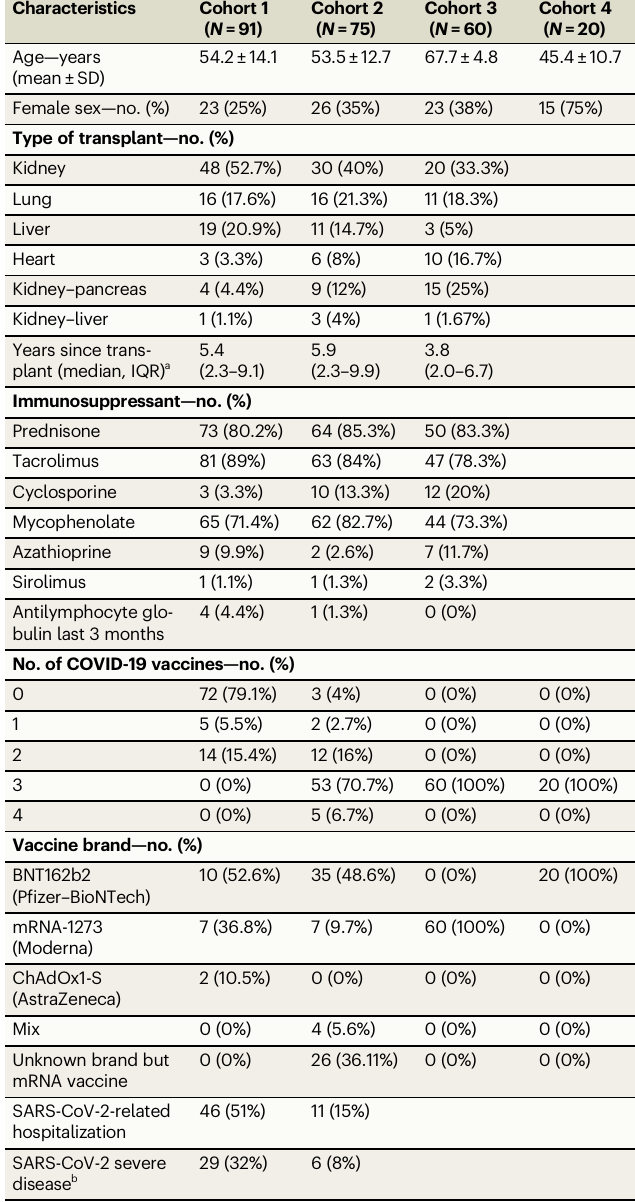
Table 1 | Demographic and clinical characteristics of the patients of each cohort at baseline